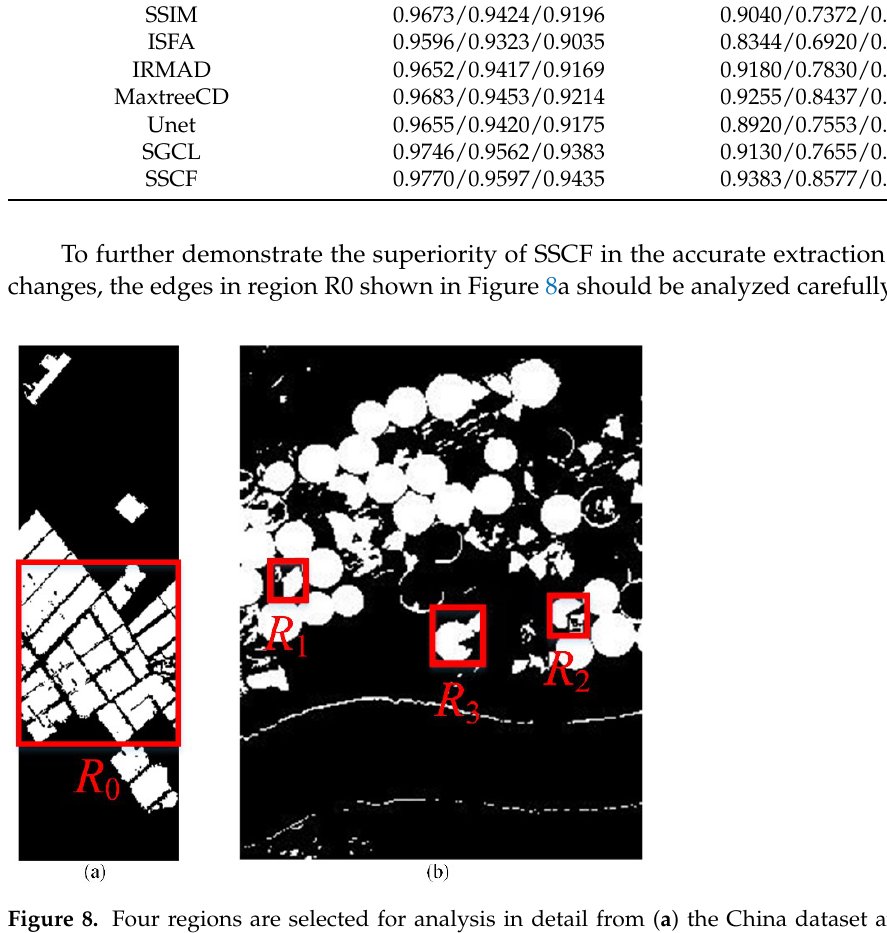
Figure 8. Four regions are selected for analysis in detail from ( a ) the China dataset and ( b ) the USA dataset.